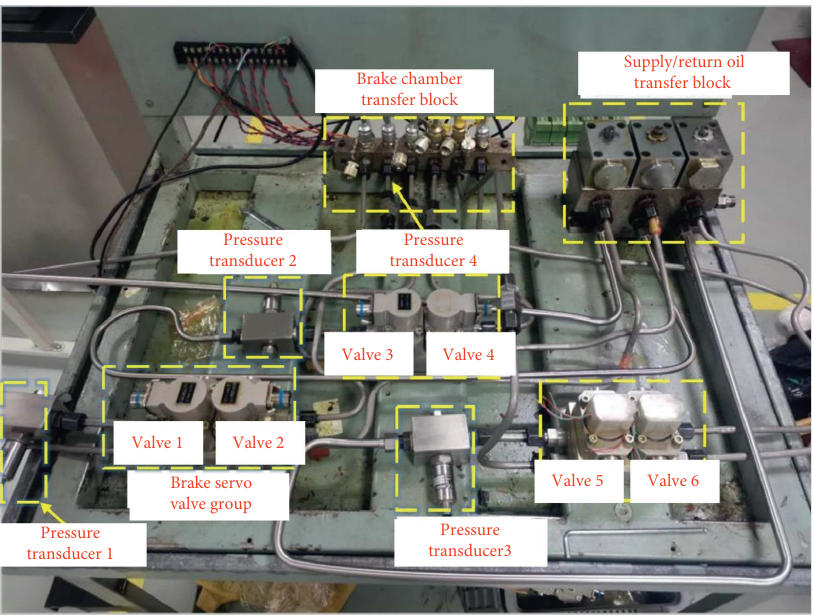
Figure 17: Te test platform for the multivalve brake system. Table 1: Parameters of the test platform.